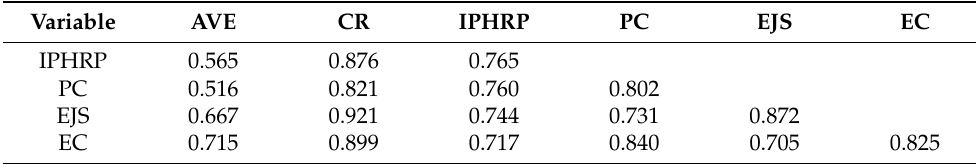
Table 3. Convergent validity of the measurement